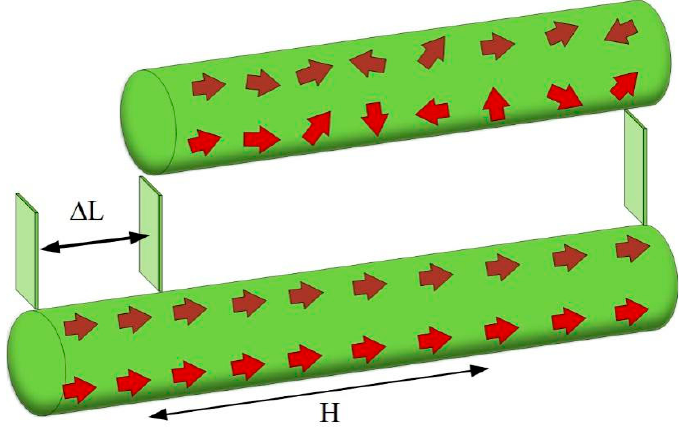
Figure 1. Magnetostriction phenomenon.